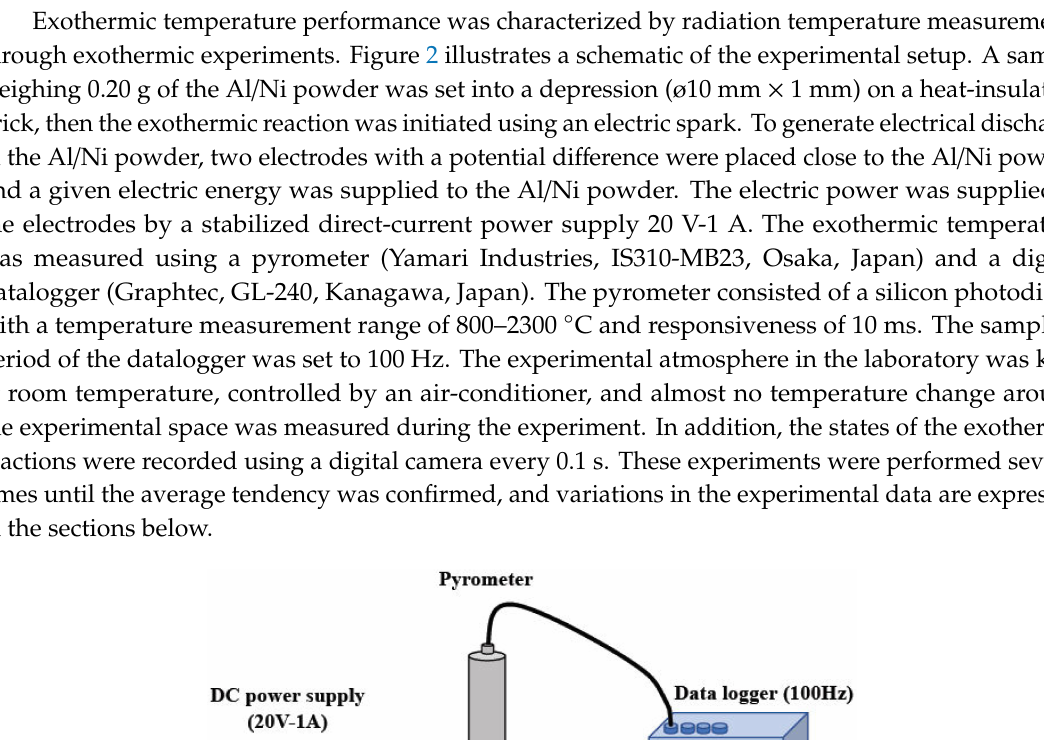
Figure 1. Schematic of the fabrication procedure of the Al / Ni multilayer powder by the cold-rolling and pulverizing methods.